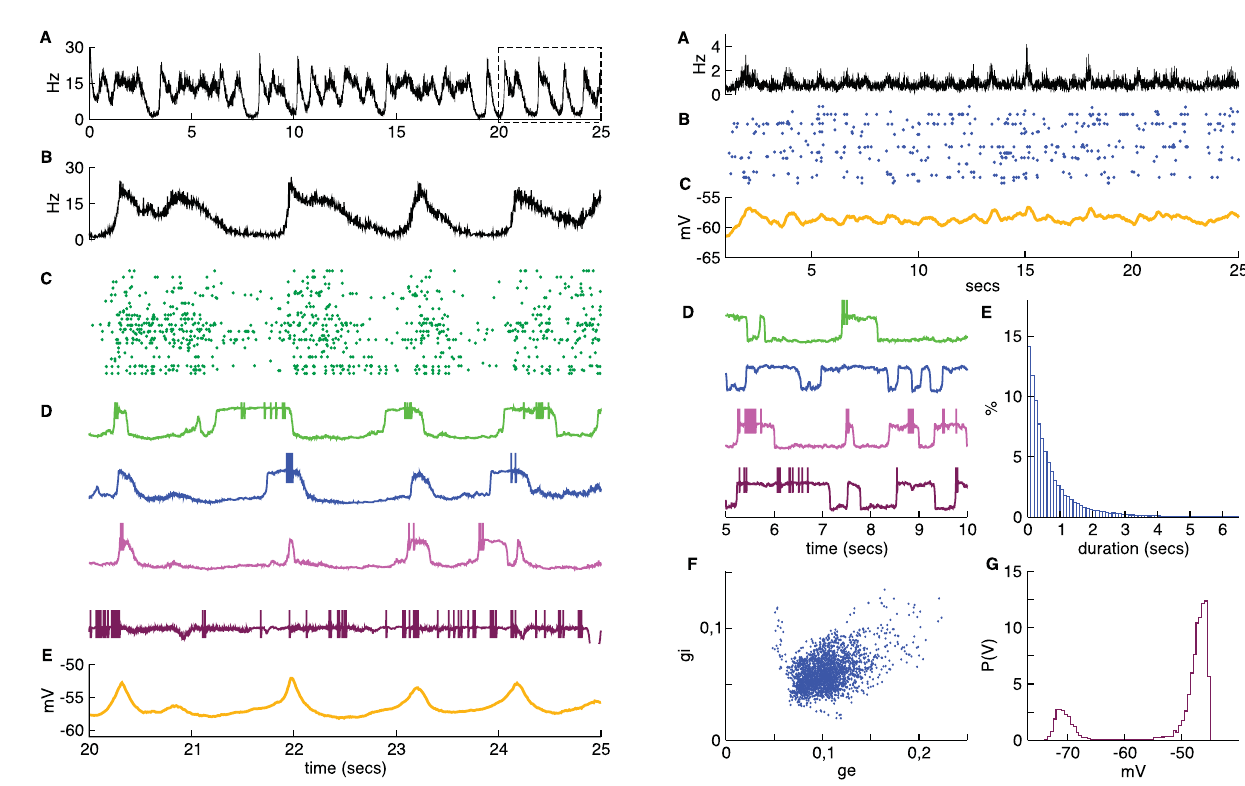
Figure 8. A rather silent network . The inhibitory conductance of the noise was increased by 10%. Neurons still make transitions between up and down states,butthesynchronyislost. (A) Averagefiringrate. (B) Raster. (C) Average membrane potential. (D) Sample membrane potential traces for the same four neurons shown in previous figures. The bottom trace (brown), which corresponds to the neuron that stayed mostly in the up state in the more active networks (brown traces in Figures 2, 5 and 7 ) now makes transitions anddevelopsabimodalpotential(panelG). (E) Histogramofupstatedurations. These are shorter than in more active networks. (F) Evolution of the average conductances, which are much smaller than in the previous networks. There is no longer any structure in the conductance